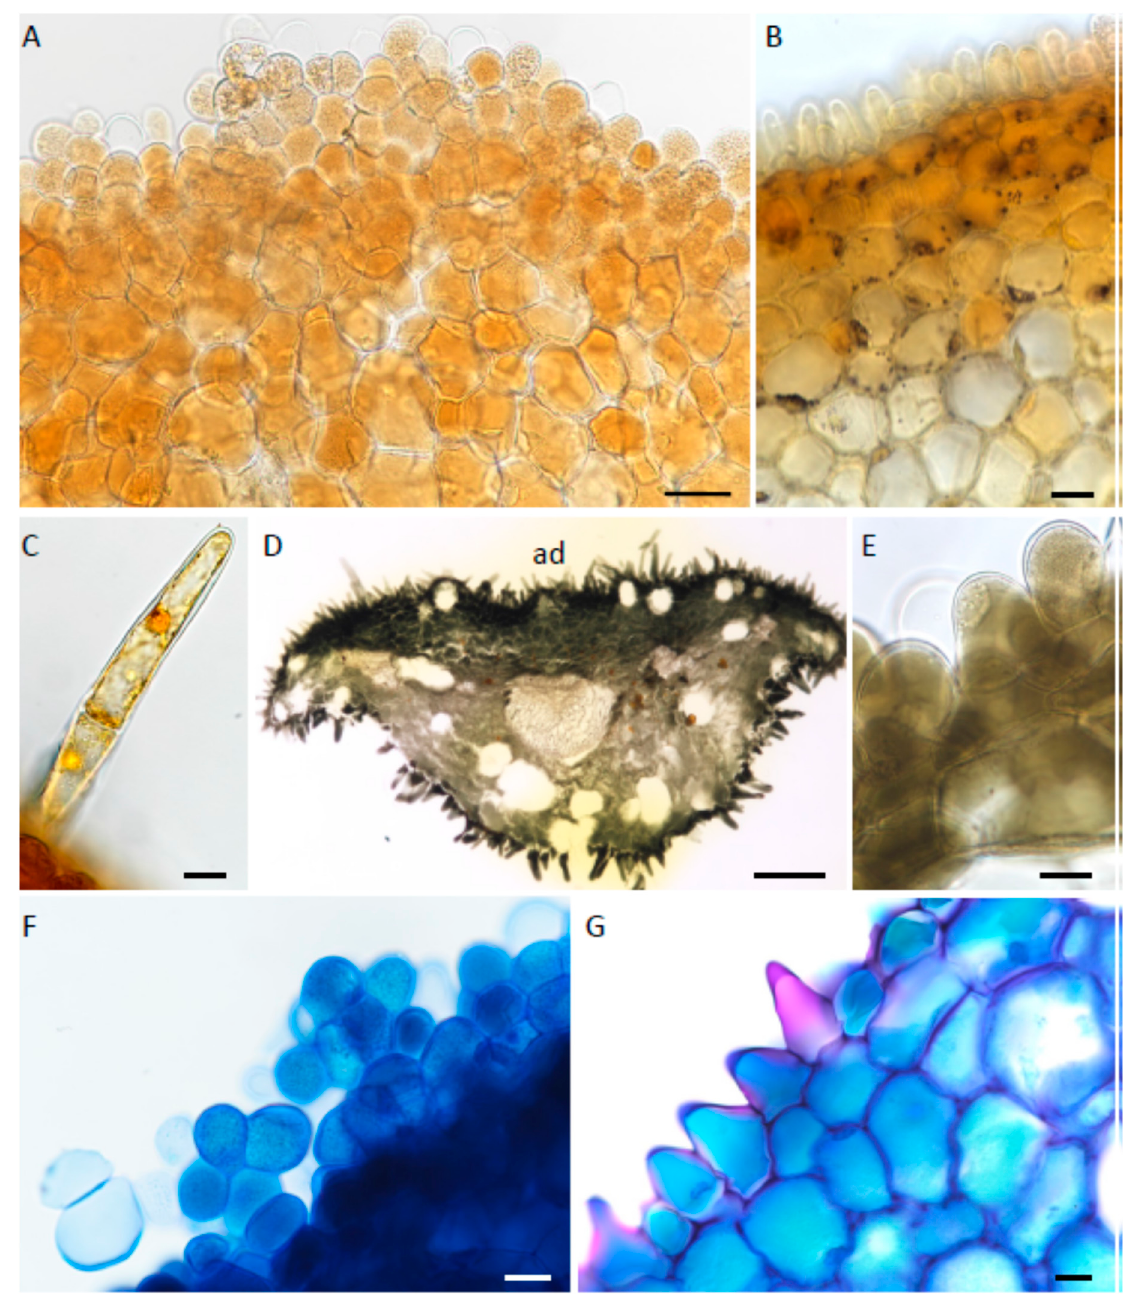
Figure 6. ( A – G ). Histochemistry of labellar tissue. ( A – C ). Labellar tissues treated with IKI for starch. ( A ). Epidermis and subepidermal parenchyma from apical part of labellum of M. pauciflora lacking obvious starch grains. ( B ). A similar preparation of M. pauciflora . Starch is present in the subepidermal parenchyma of the callus region. ( C ). Trichome of M. pauciflora lacking starch reserves. ( D , E ). Labellar tissues treated with FeCl 3 for polyphenolic compounds. ( D ). Hand-cut, transverse section through the apical part of the labellum of M. weberbaueri . Note the intense staining of the epidermal papillae and subepidermal parenchyma. Large idioblasts are visible in the ground parenchyma. ( E ). Adaxial epidermal papillae and subepidermal parenchyma of M. ochroleuca . ( F , G ). Hand-cut, transverse sections of the apical part of the labella of M. pauciflora and M. weberbaueri , respectively, stained with TBO. Vacuoles of both epidermal papillae and subepidermal parenchyma cells stained blue-green. Scale bars = 50 µ m, 20 µ m, 15 µ m, 200 µ m, 20 µ m, 20 µ m, 20 µ m, respectively. ad = adaxial